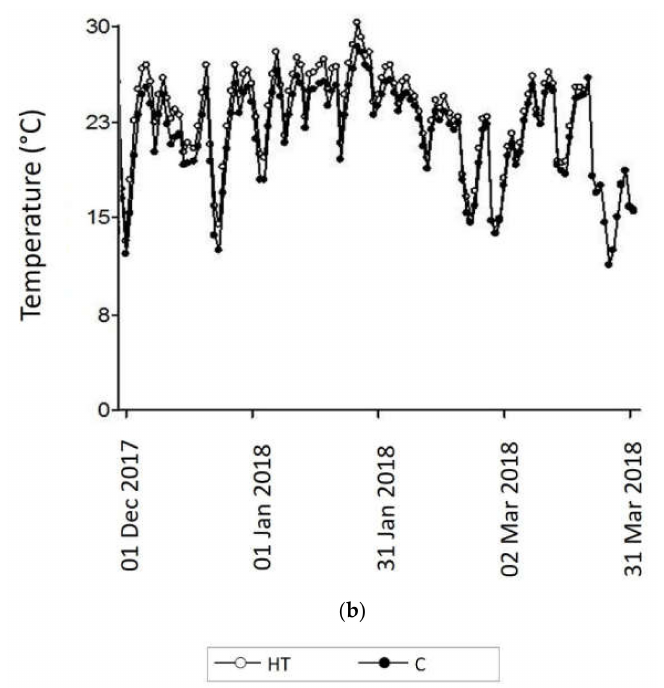
Figure 1. Daily mean diurnal temperatures ( ◦ C) for the high temperature (HT) and Control (C) treatments during the experimental period in seasons 2017 ( a ) and 2018 ( b ). Error bars represent standard errors for three replicates.